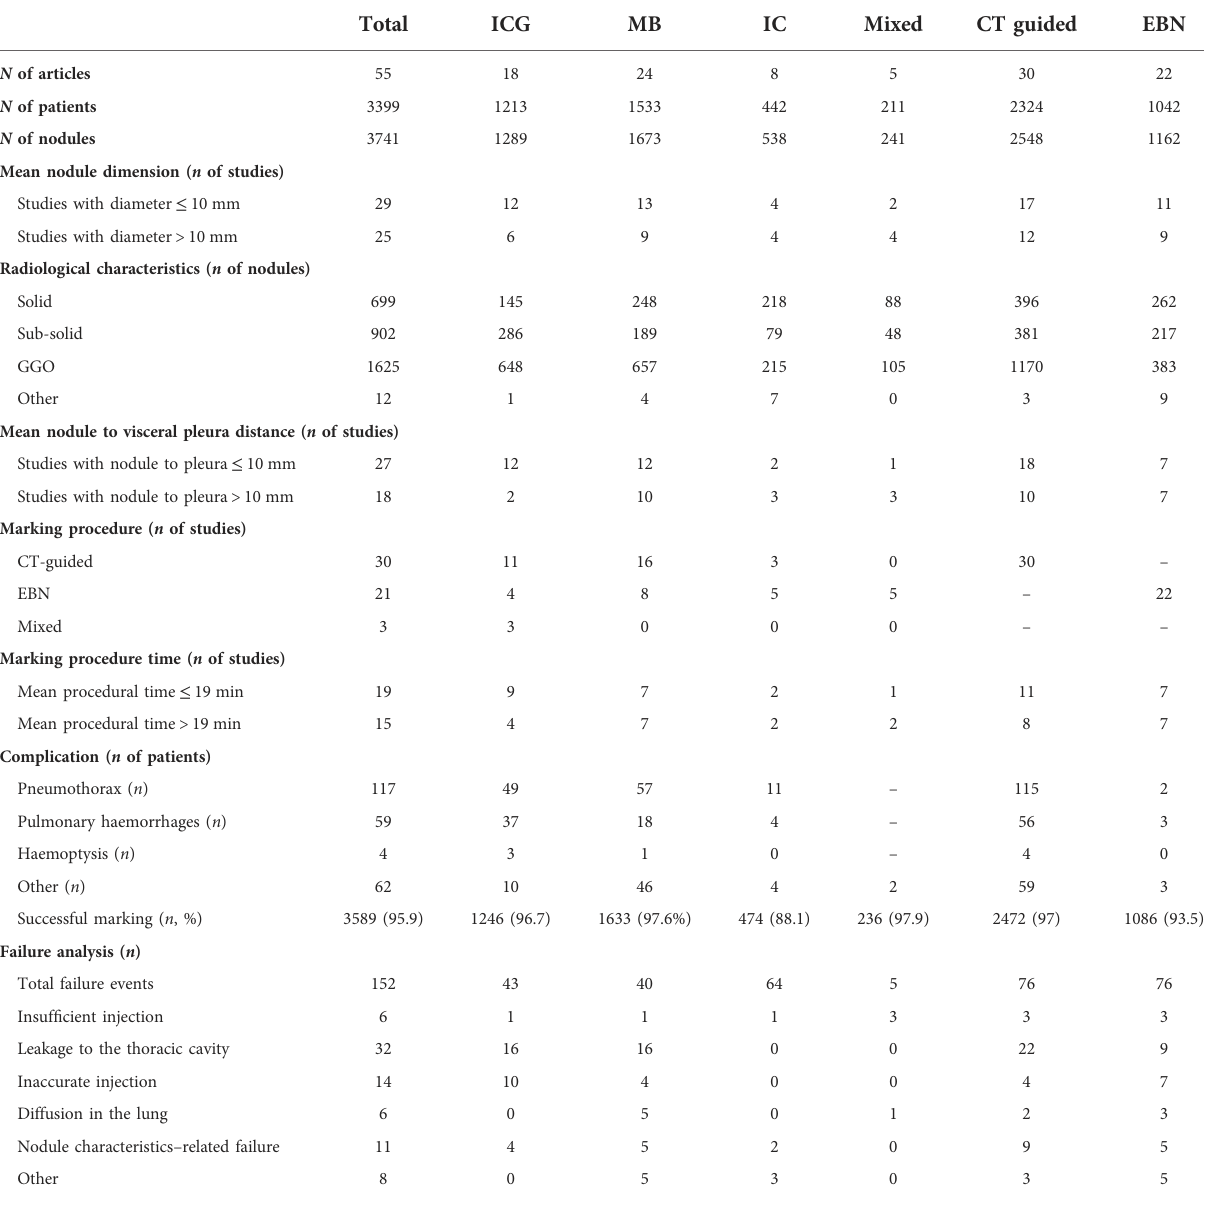
TABLE 1 Patients and techniques